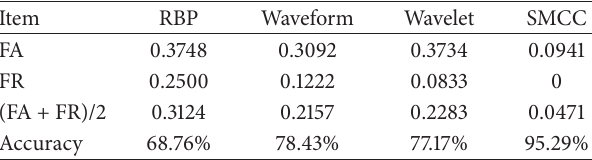
Table 1: FA/FR of the compared